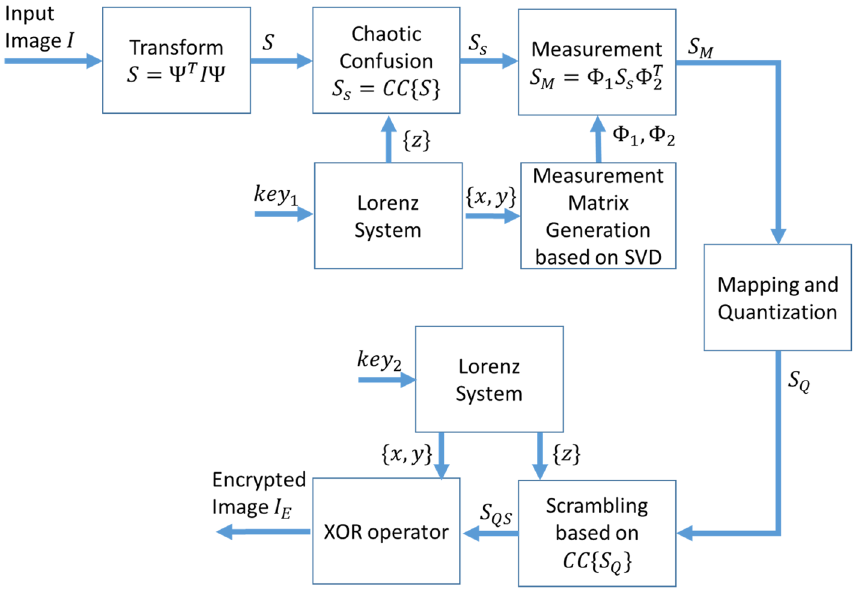
Figure 2. The block diagram of the proposed encryption